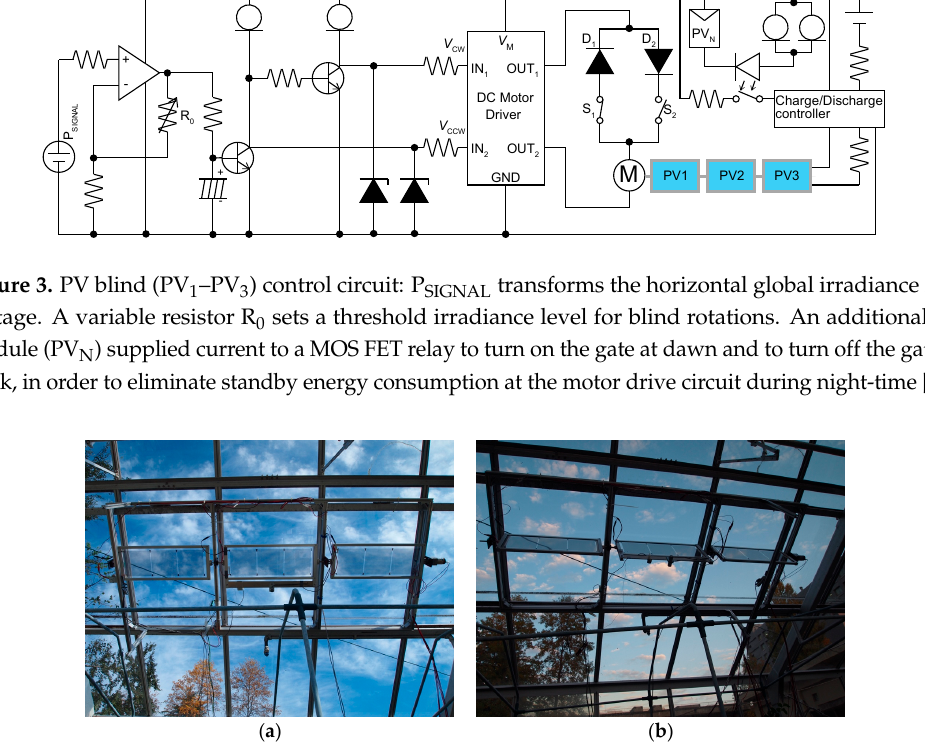
Figure 4. Semi-transparent PV blind installed underneath the greenhouse glass roof facing the eastern sky: the PV blind inclined at parallel (( a ), θ = 0°) or perpendicular (( b ), θ = 90°) to the roof surface. Supplemental Video S1 is available to see the PV blind operations on 2 March 2018.